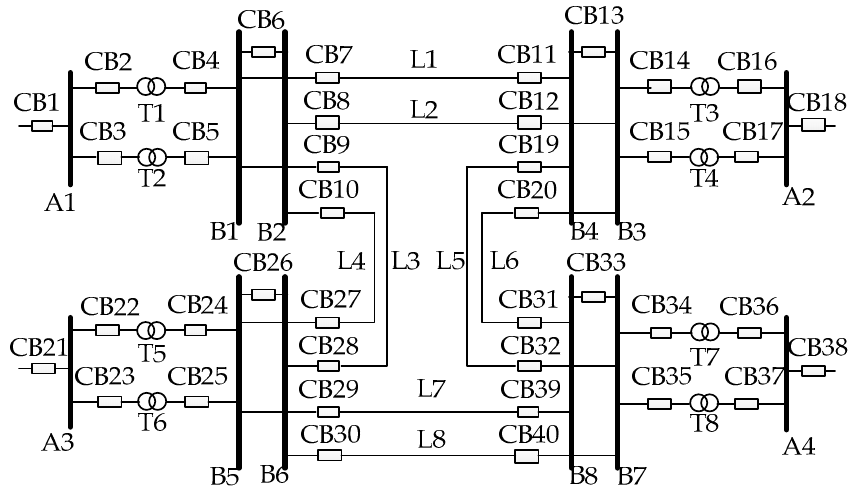
Figure 7. The tested four-zone power system.